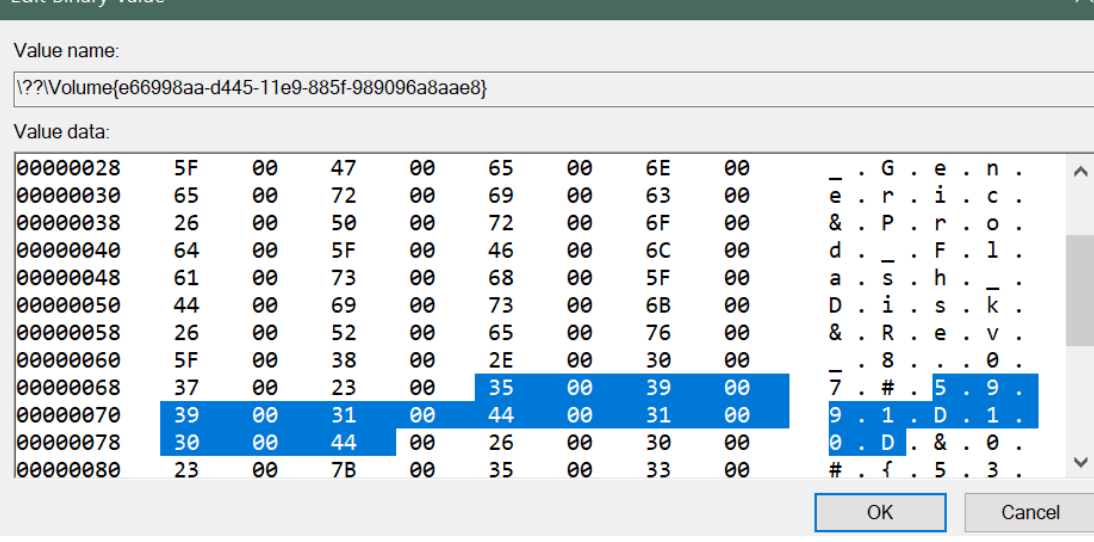
Figure 18. USB device GUID.